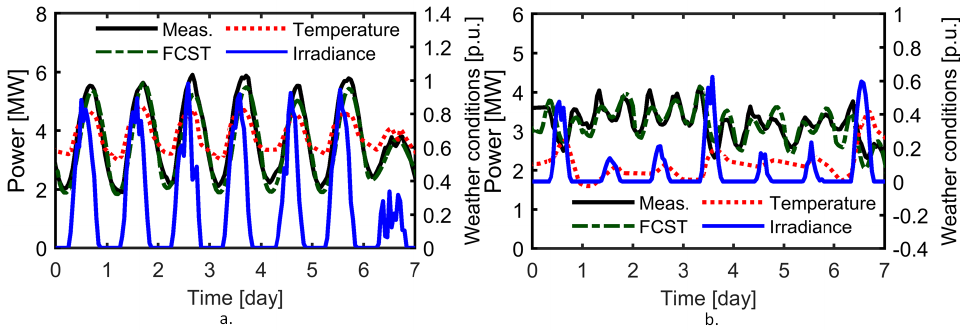
Figure 5. Total load measured and forecasted for 2020 example weeks starting on 4 June ( a ) and 27 January ( b ). Also plotted and illustrative of the correlation are the weather conditions, which are specified in the p.u. system with a reference outdoor temperature of 40 ◦ C and a solar irradiance of 1000 W/m 2 , which is used throughout the paper unless specified otherwise.